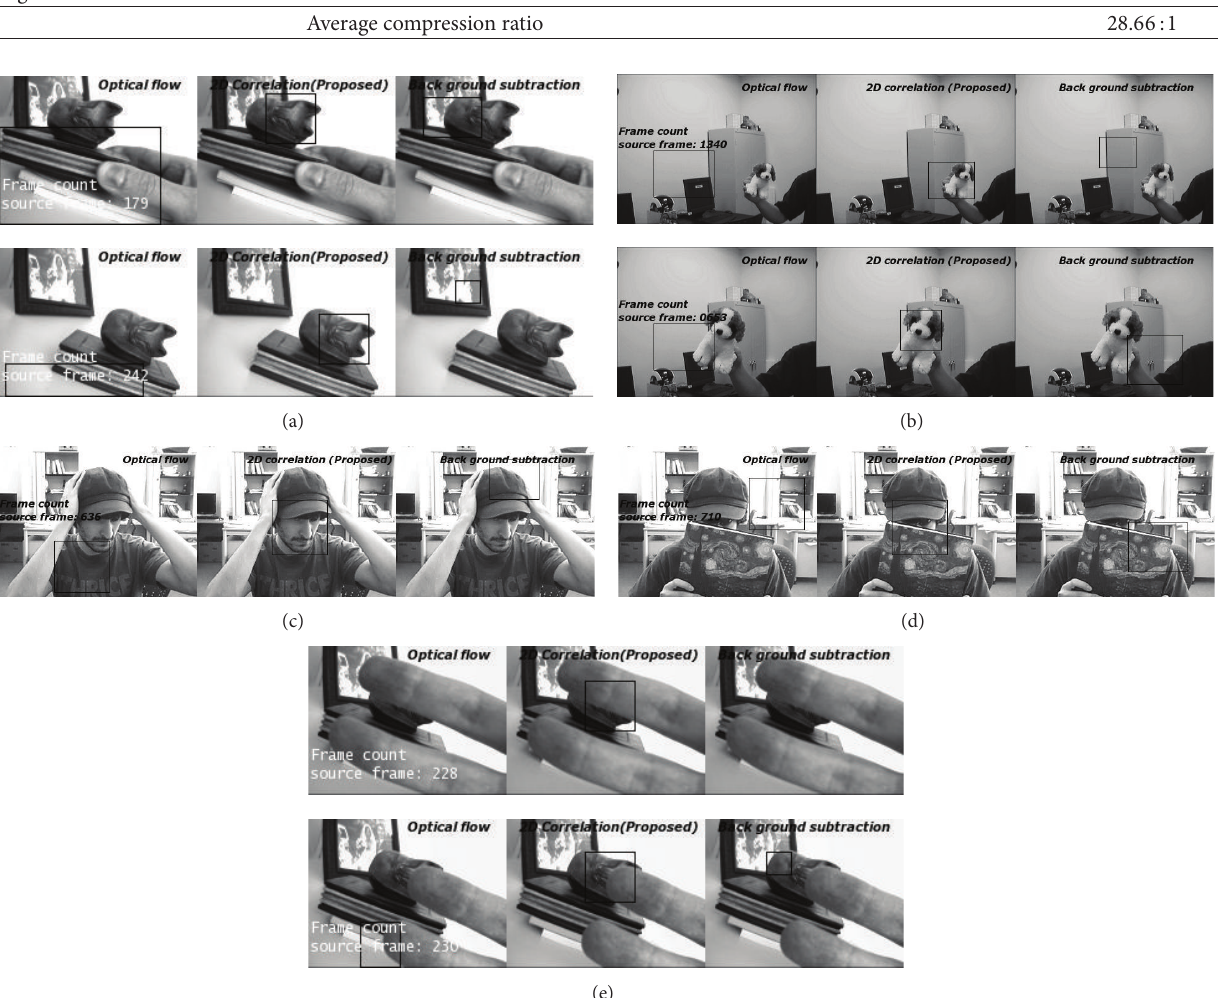
Figure 3: (a) Tracking results under target translations on cat video.bin. (b) Tracking results under target variations on Dog1 data set. (c) TrackingresultsundertargetvariationsonFaceOcc2dataset.(d)TrackingresultsundercompleteocclusiononFaceOcc2dataset.(e)Tracking results under partial occlusions on cat